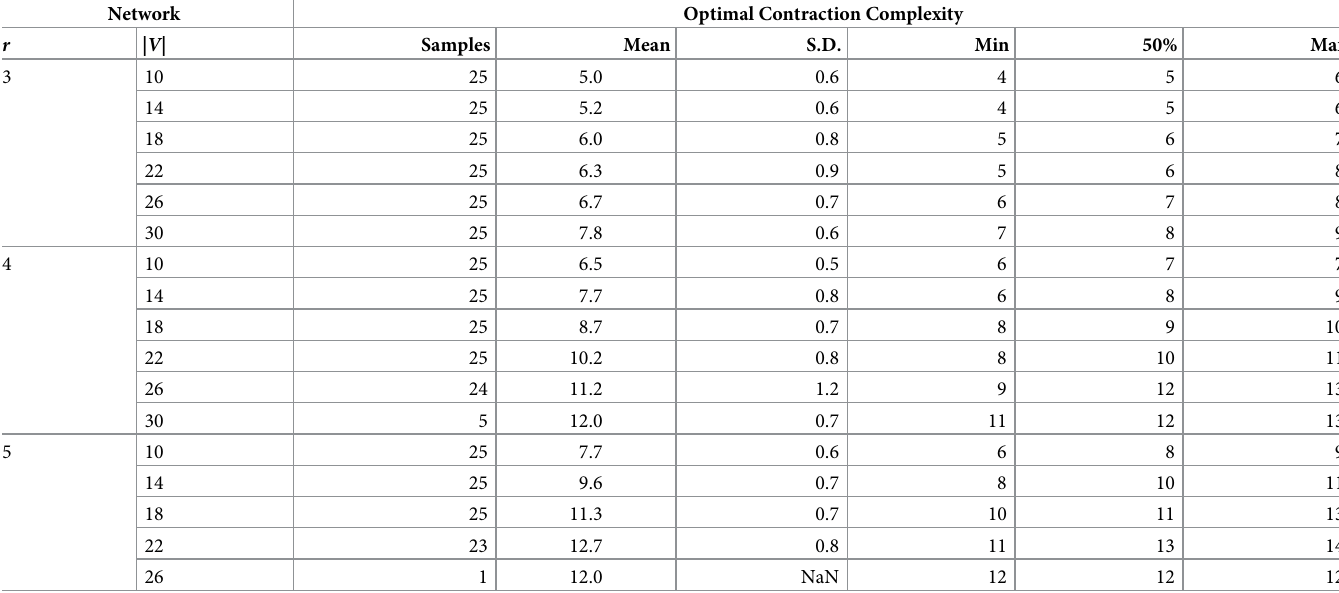
Table 2. Exact contraction complexities found using freetdi and meiji-e on QAOA circuits for computing M AX C UT on r -regular graphs. 25 random regular graphs are generated at each r , | V | level using NetworkX, and algorithms were timed out at 15 minutes. Timed out values were dropped from the data, resulting in less than 25 Samples for some parameter